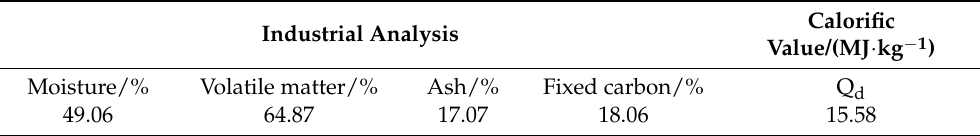
Table 2. Industrial analysis and calorific value analysis of the chicken manure. Industrial